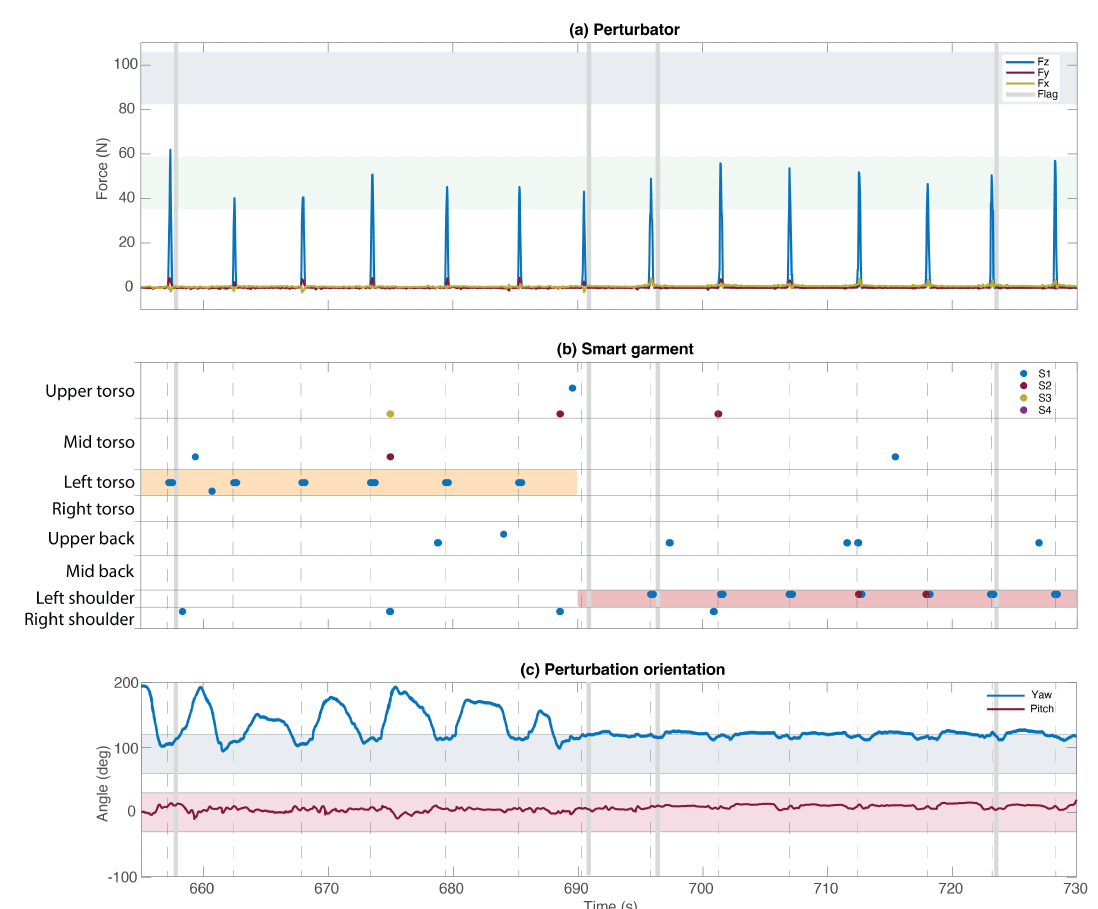
Figure 8. Data extracted from the experiment where the participant was not wearing the exoskeleton. The execution of conditions 13 (left side torso—Low) and 14 (left side shoulder—Low) is represented. The pre-defined tolerance ranges for the magnitude, location, and orientation are represented by the colored areas: ( a ) Perturbator—Low perturbations area in green, and High perturbations area in blue; ( b ) Smart garment—left torso area in orange, and left shoulder area in red; ( c ) Yaw angle area in blue, and pitch angle area in red. On the ( b ) Smart garment subplot, S1 to S4 refer to the four most active sensors registered at a time. At least one active sensor must be within the targeted area of the garment to comply with the location of the perturbation. Vertical gray bars represent the flag provided by the BenchBalance system to identify the discarded perturbations due to non-compliance with any of the tolerance ranges of magnitude, duration, location, or